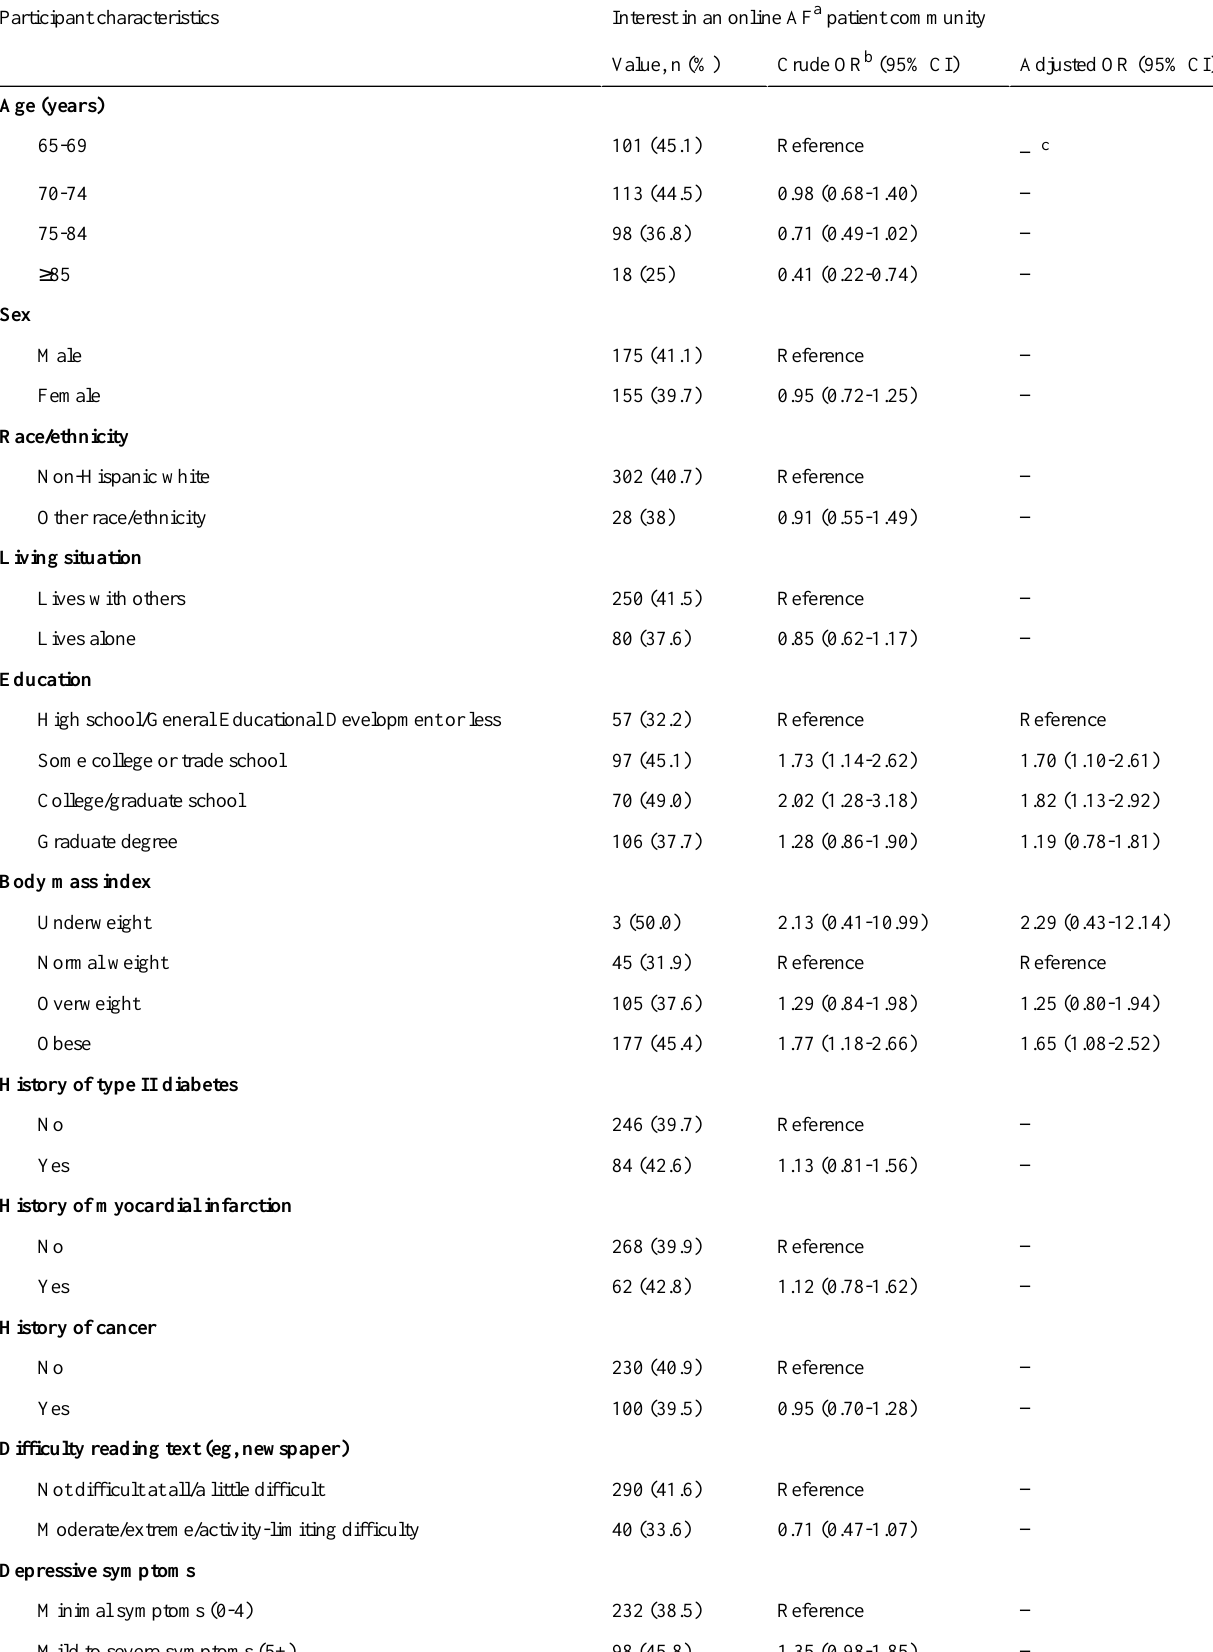
Table 3. Interest in online atrial fibrillation patient community in relation to demographic, clinical, psychosocial, and technology use characteristics of online older adults with atrial fibrillation (N=816), Systematic Assessment of Geriatric Elements in Atrial Fibrillation (SAGE-AF)